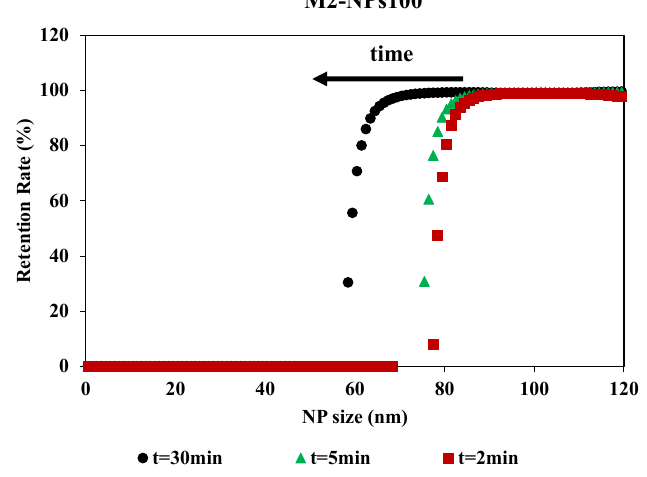
Figure 6. Retention rate of NPs100 in function of NPs size for the filtration with membrane M2 over the time realized [TMP 0.5 bar].